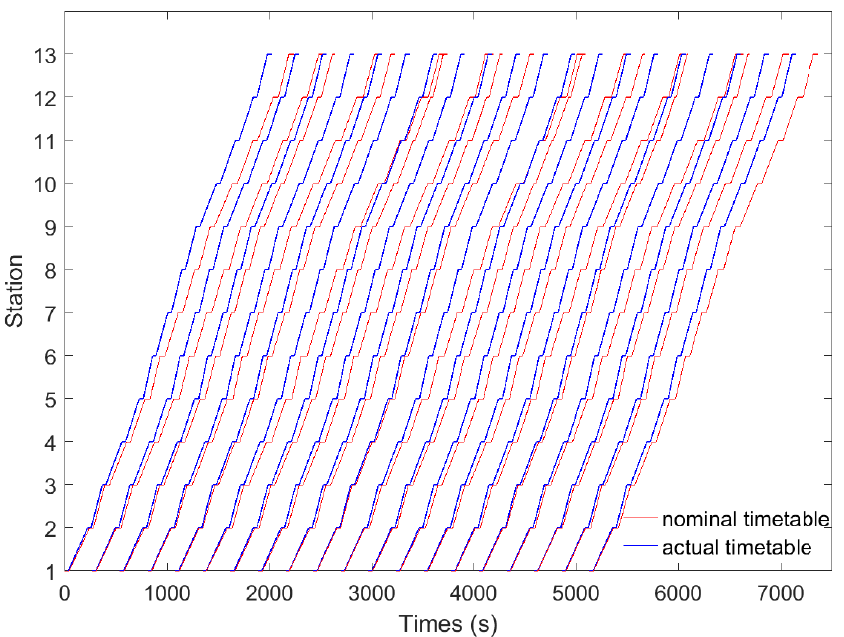
Figure 4. The timetable without train regulation under Case 1 in contrast to the nominal timetable.